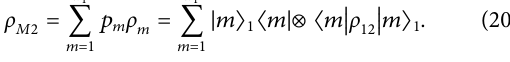
Frontiers in Physics |